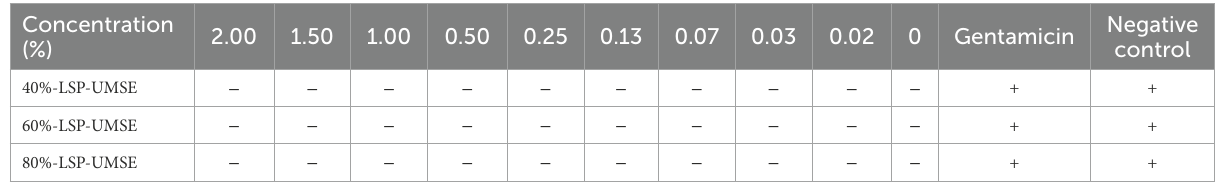
TABLE 4 In vitro safety of LSP against L. casei - dye